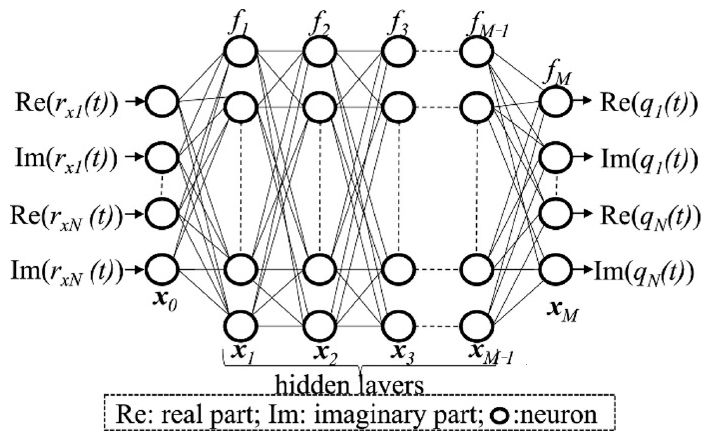
Figure 23. The structure of DLNN.